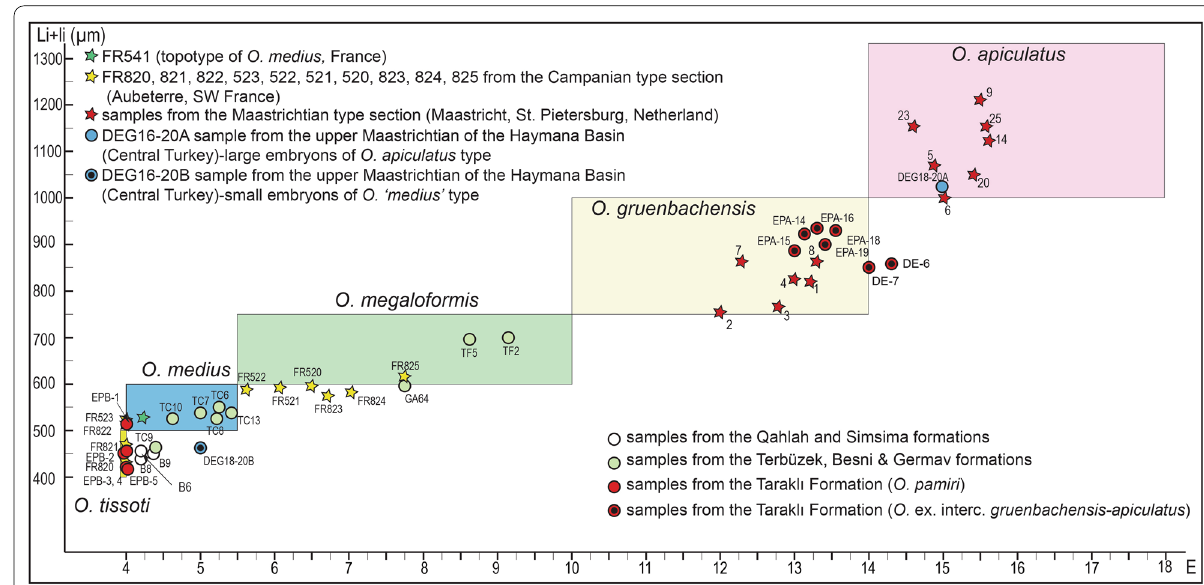
Fig. 16 Scatter diagram showing the relation between the average number of epi-embryonic chamberlets (E) and embryon size (Li studied Orbitoides populations from Epçeler and Dereköy. Data from the Campanian and Maastrichtian type sections and the upper Maastrichtian Beyobası Formation (samples DEG 16-20) from the Haymana Basin are also shown. Species limits after van Hinte (1976). Data from the Campanian type section (samples FR 820, 821, 822, 523, 522, 521, 520, 823, 824 and 825 in ascending stratigraphic order) are from van Hinte (1966b) and those from the Maastrichtian type section (samples 1–9, 12, 14, 23, 25) are from Baumfalk and Willemsen